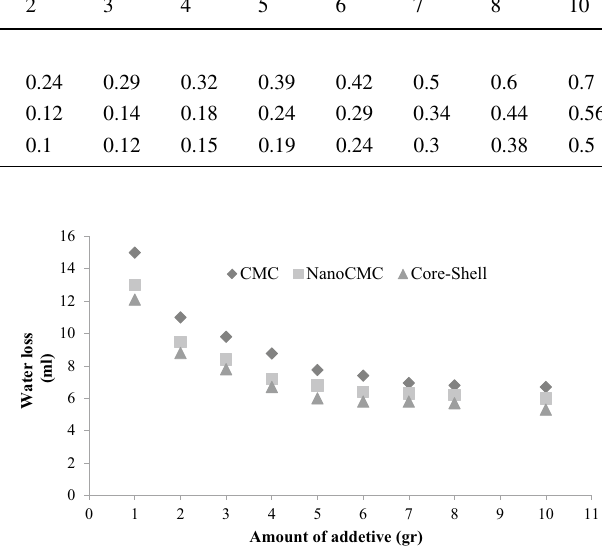
Table 1 Mud cake thickness